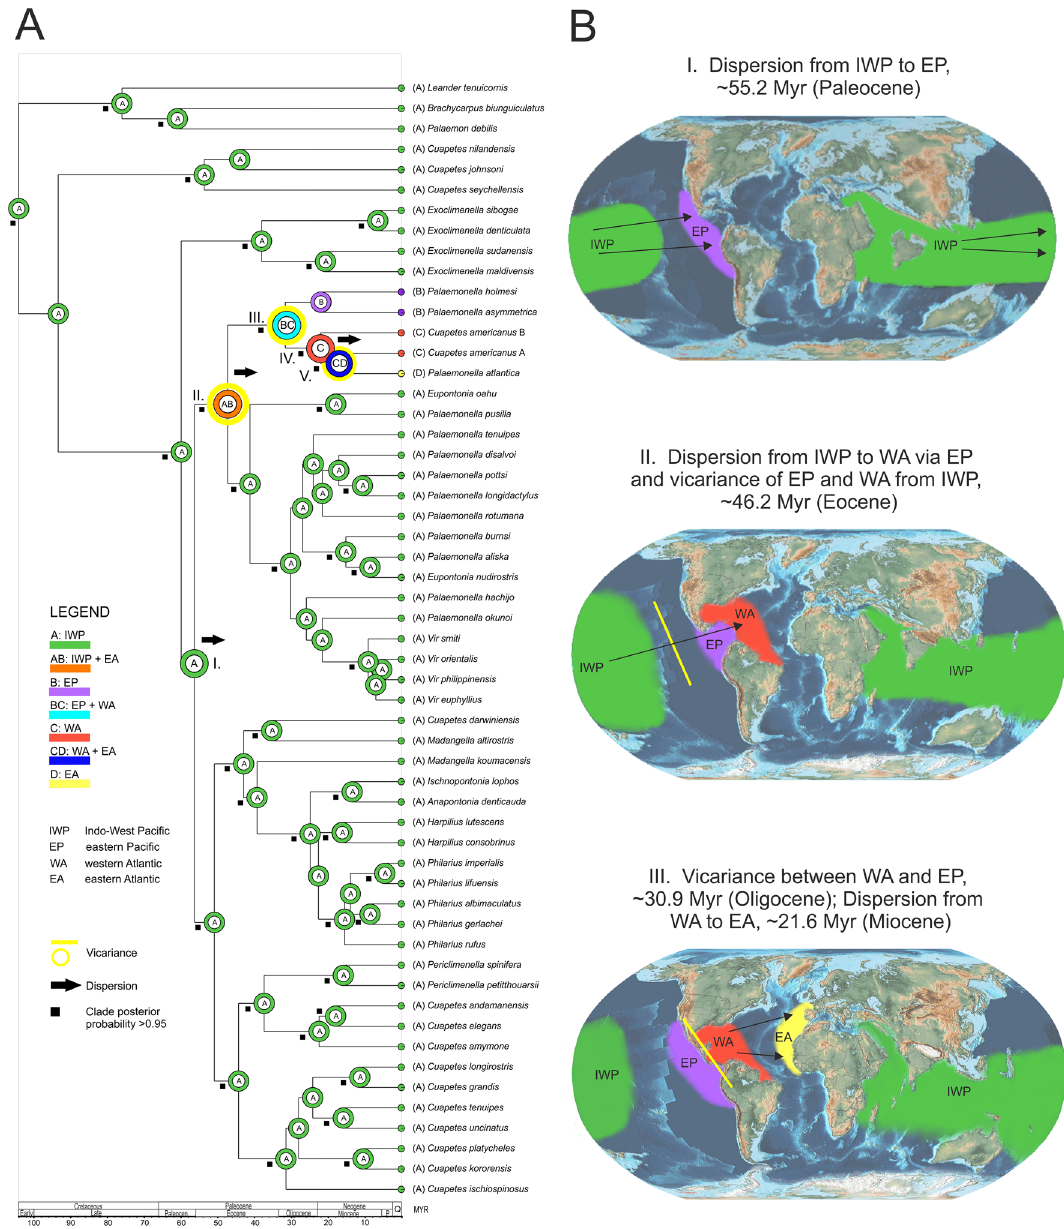
Figure 4. Biogeographic history of palaemonid shrimp (Pon-I group). ( A ) Results from S-DIVA analysis (performed in RASP) of ancestral distributions at each node of the phylogeny. Each node shows the most likely ancestral area for the node. Tree topology is based on BEAST analysis. Geographical areas are coded with letters and colours. ( B ) Paleogeographic maps showing the vicariant and dispersal events. Maps were created using GPlates v2.3 software (http:// www. earth byte. org/ paleo map- paleo atlas- for- gplat